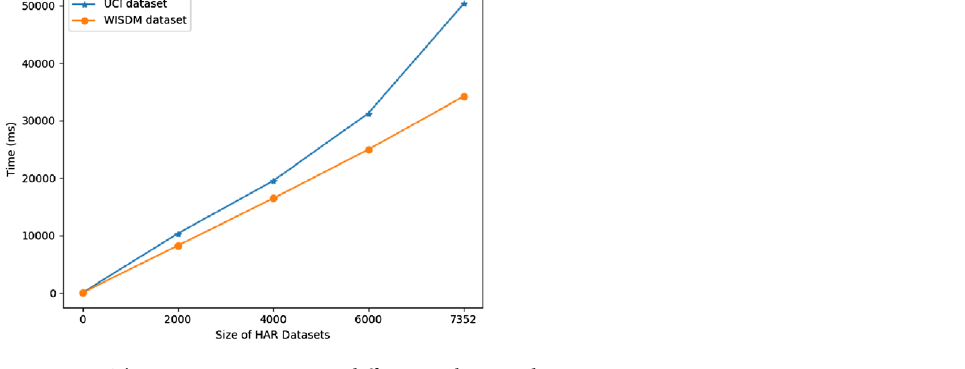
Figure 13. The time consumption on different scale HAR datasets.